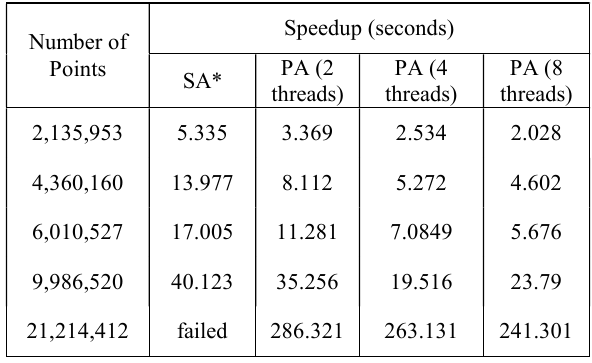
Table 1. Performance comparison between the Paralleled Delaunay Algorithm (PA) and the Sequential Algorithm (SA) From Table 1, we can see that the paralleled algorithm can improve the speed of Delaunay triangulation of LiDAR point cloud significantly. For example, for a data set with 2,135,953 points, the sequential algorithm takes 5.335 seconds while the paralleled algorithm with 4 threads takes only 2.534 seconds. For a data set with 9,986,520 points, the sequential algorithm takes 40.123 seconds while the paralleled algorithm with 4 threads takesonly 19.516